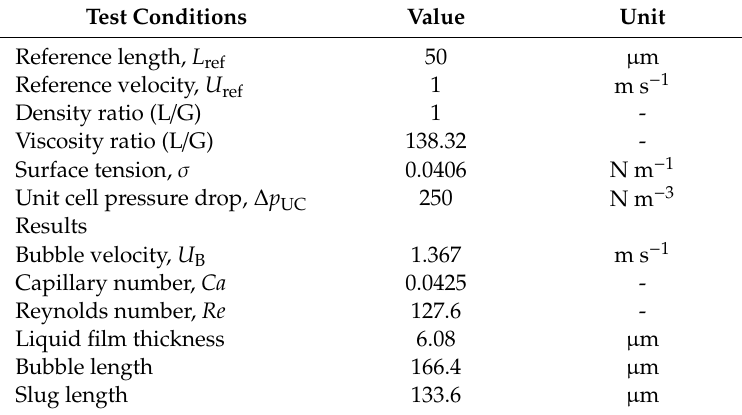
Table 2. Test conditions and results of hydrodynamic simulation.